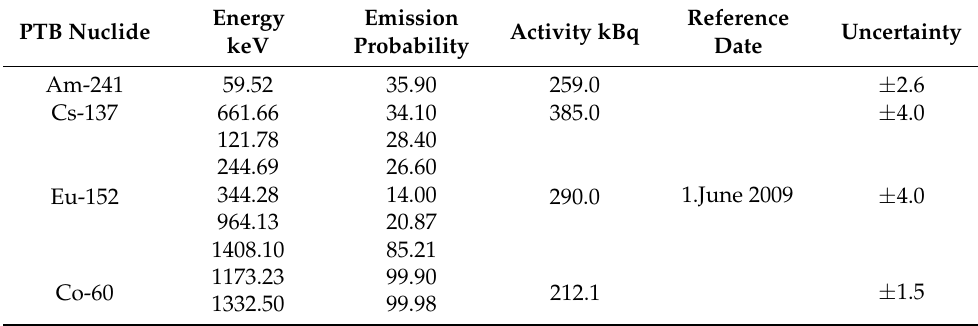
Table 2. The radioisotopes point source